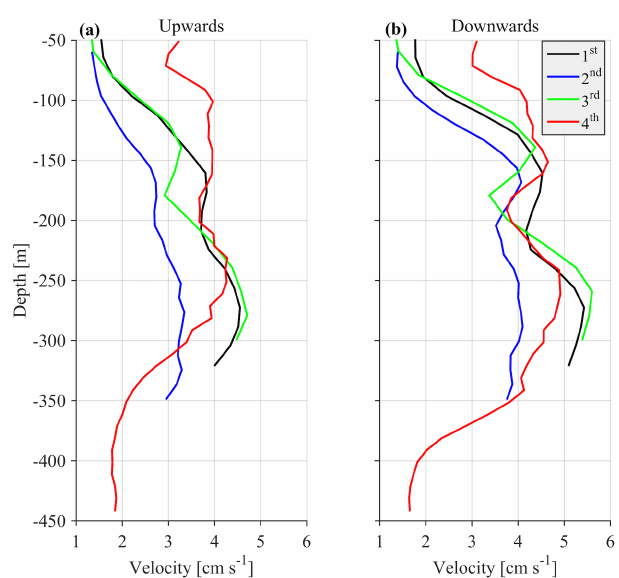
Figure 2. Time average burst velocities per ADCP